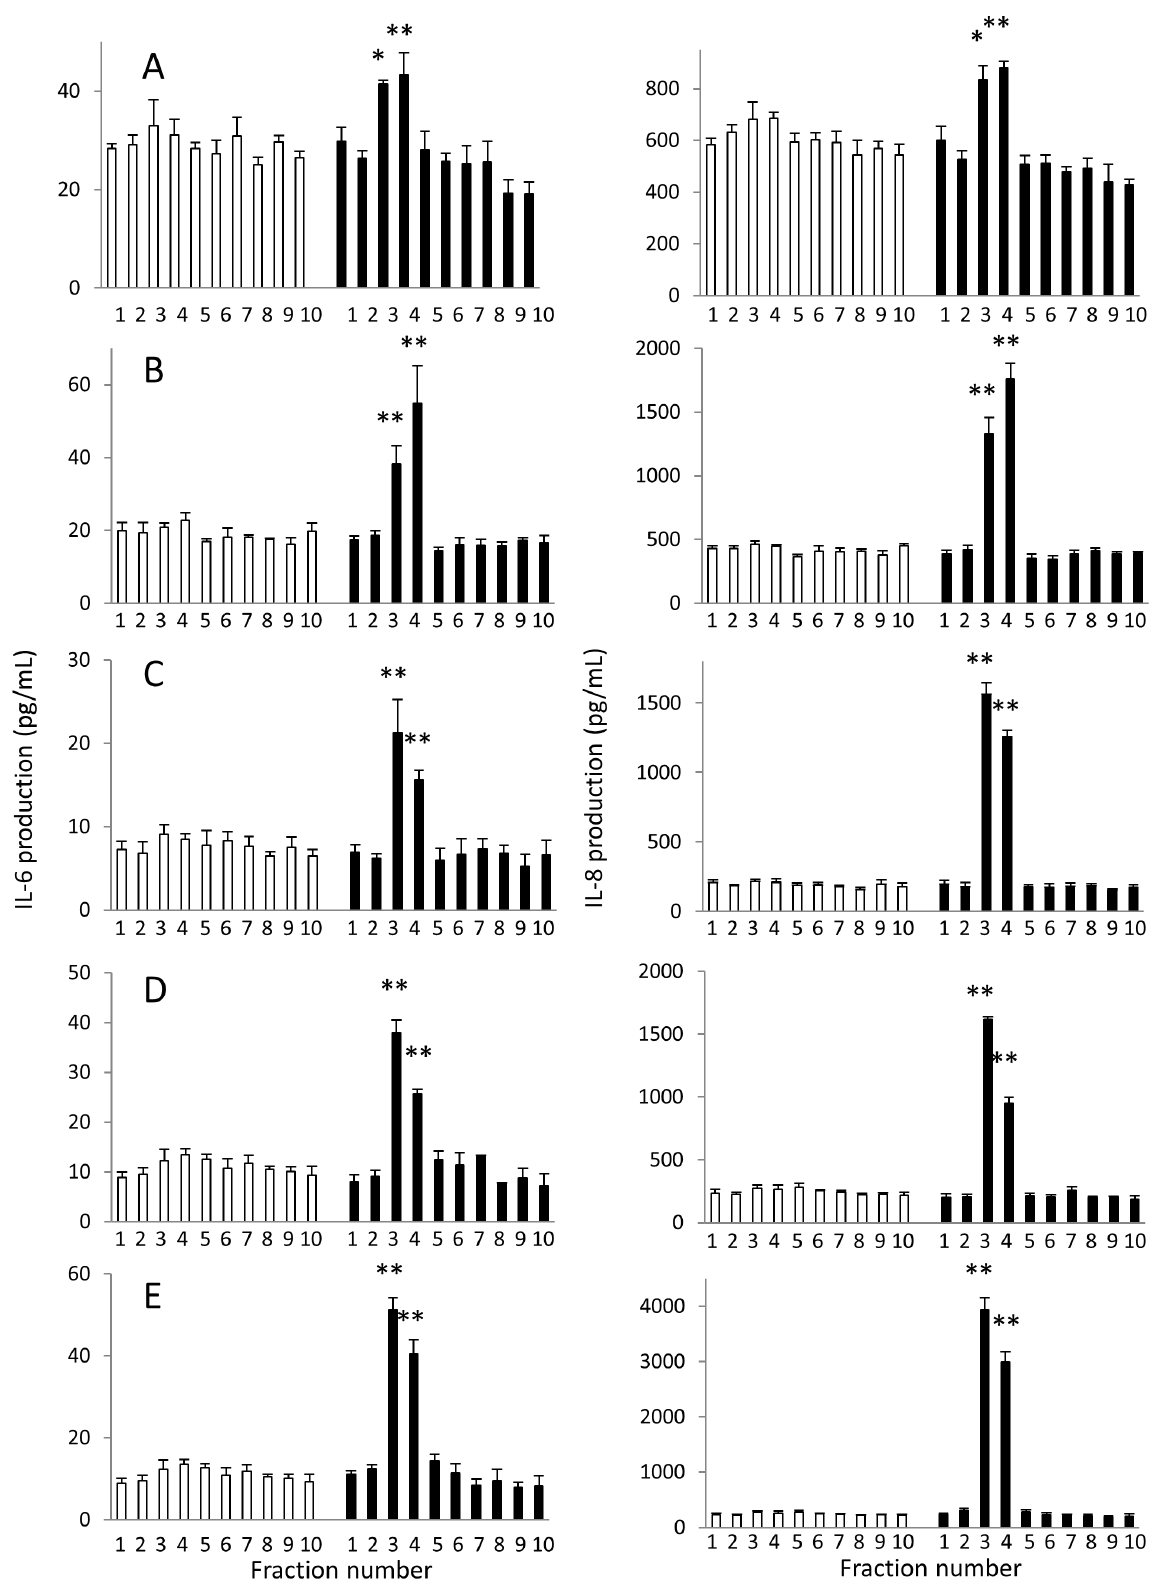
Figure 7. Fractionation of HCAEC-activating biofilm lipid extracts by HPLC. Each biofilm lipid extract from Y. pseudotuberculosis (A), B. cereus (B), B. subtilis (C), S. aureus (D) or P. aeruginosa (E) was separated into 10 fractions by HPLC and assayed for the stimulatory activity of HCAECs ( & ). Fractions 3 and 4 from each biofilm lipid extract induced high cytokine production by HCAECs. Ethyl acetate lipid extracts from glass slides in the